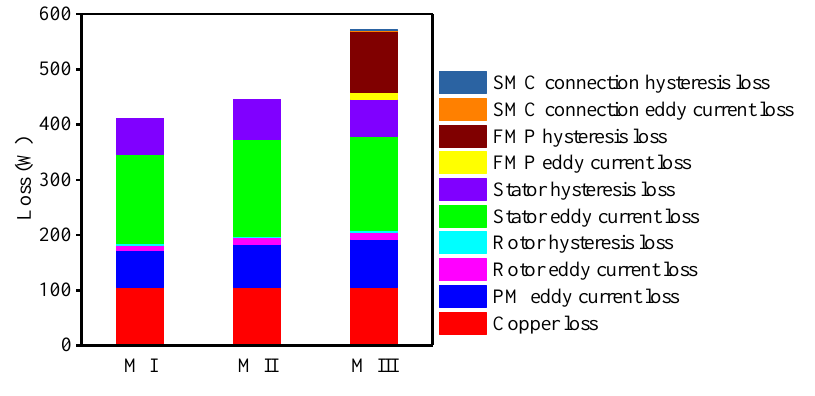
Figure 9. On-load loss comparison of the three PMVMs .